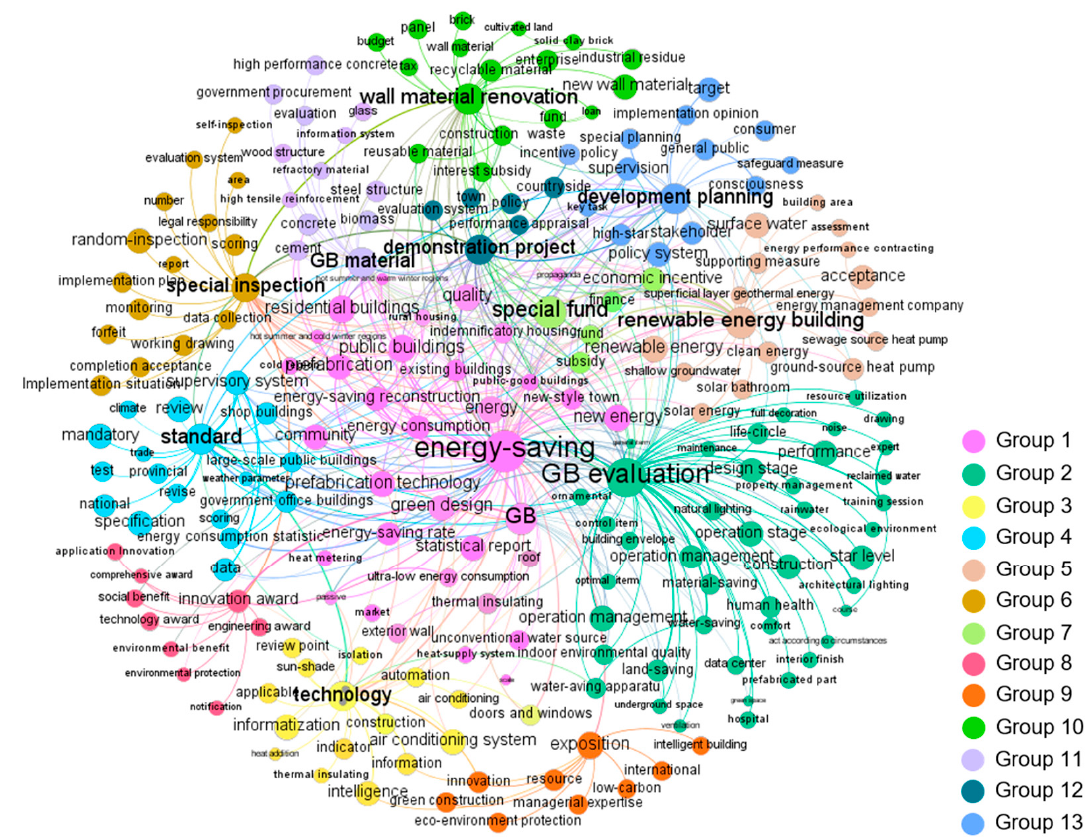
Figure 5. Co-word network of China’s GBPs in stage 4.